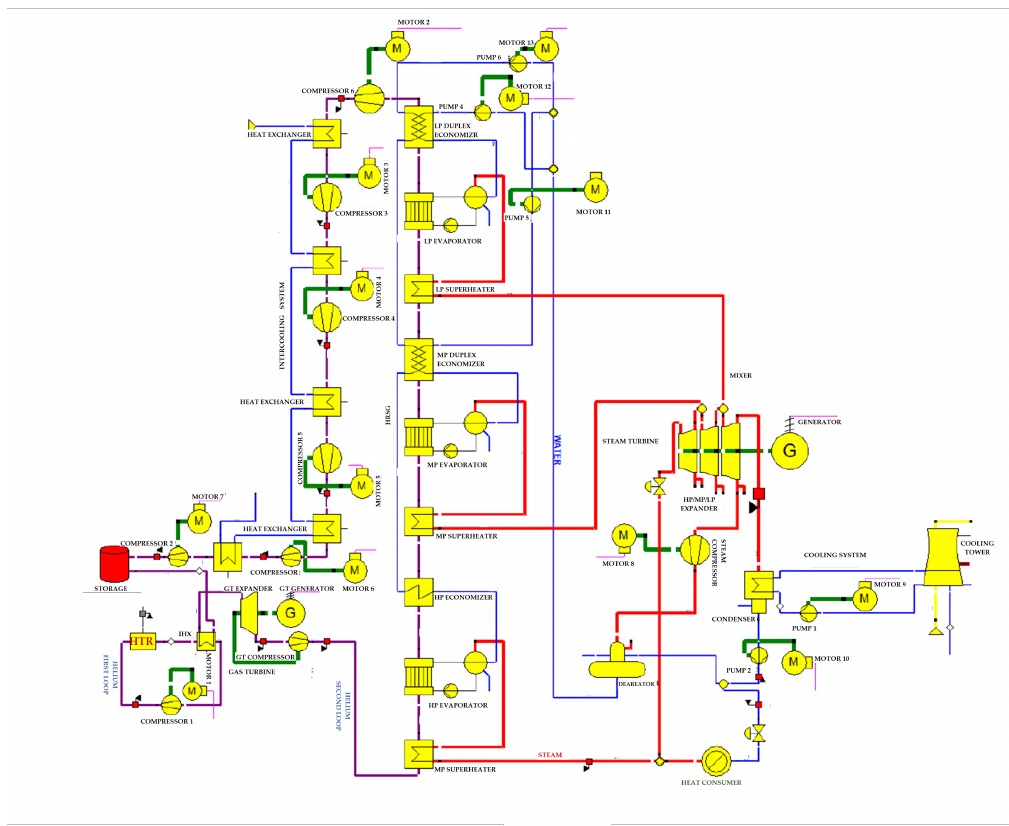
Figure 1. The HTR coupled with a gas turbine combined cycle and with 3P-HRSG